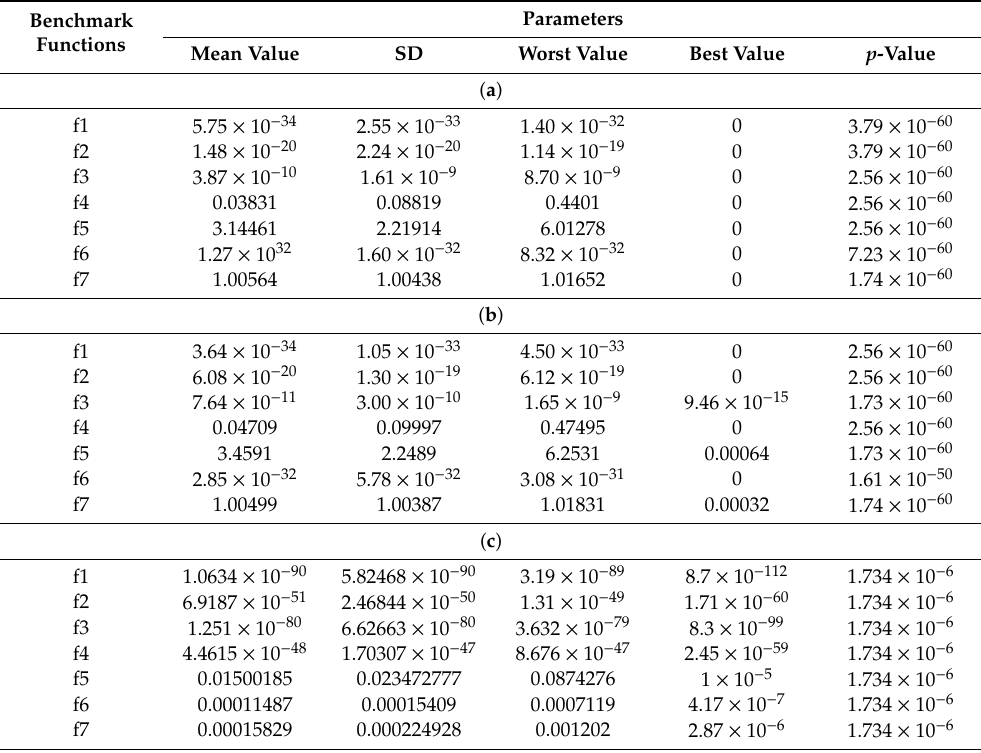
Table 4. ( a ) Outcomes of the BMFO1 algorithm. ( b ) Outcomes of the BMFO2 algorithm. ( c ) Outcomes of the HHO